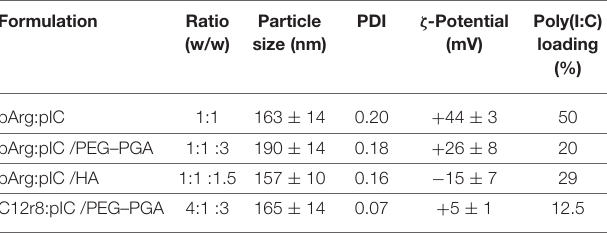
TABLE 1 | Summary of the main physicochemical properties of the four enveloped nanocomplexes used in the in vitro experiments.